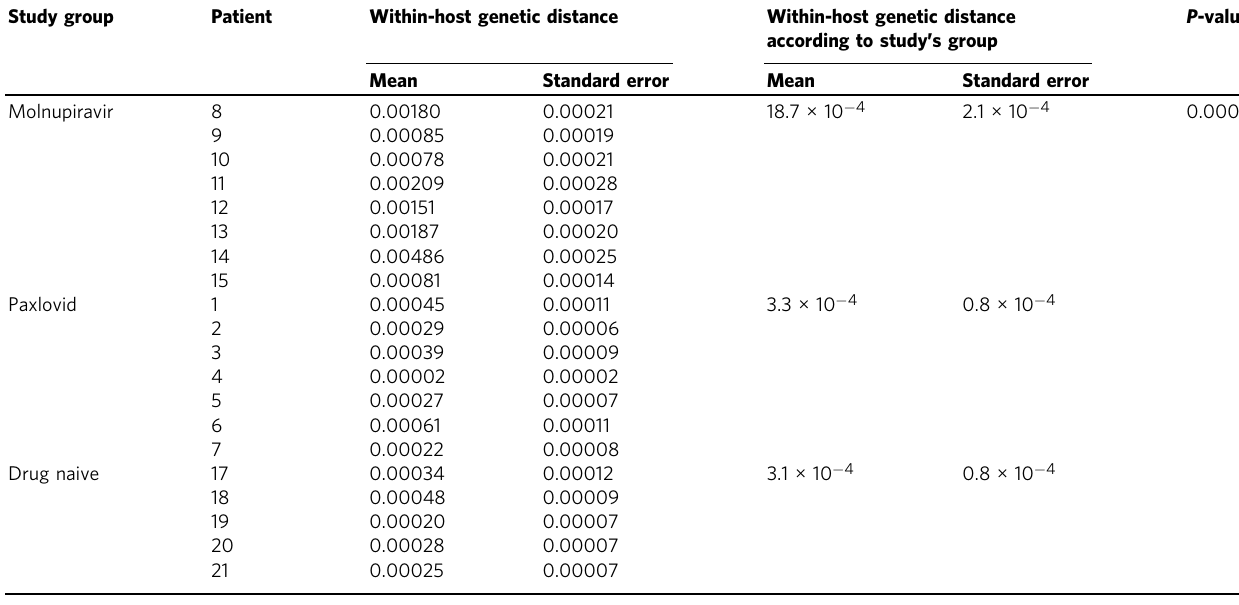
Table 2 Within-host genetic distance according to study groups. Study group Patient Within-host genetic